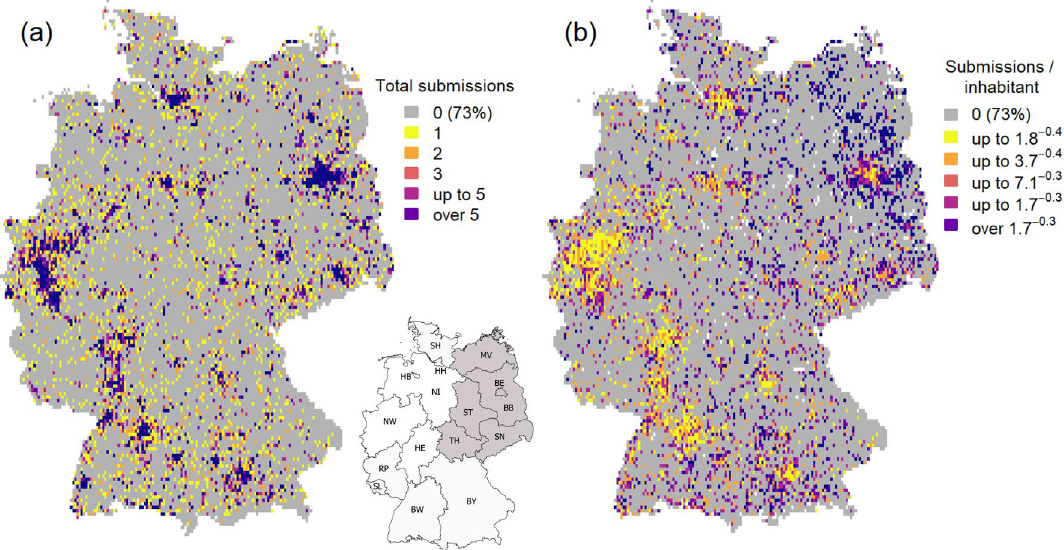
Figure 4. Federal states of Germany ( SH Schleswig-Holstein, HH Hamburg, HB Bremen, NI Lower Saxony, NW North Rhine-Westphalia, HE Hesse, RP Rhineland Palatinate, SL Saarland, BW Baden-Wuerttemberg, BY Bavaria, MV Mecklenburg Western-Pomerania, BB Brandenburg, BE Berlin, ST Saxony-Anhalt, SN Saxony, TH Thuringia). ( a ) Raster grid of Germany (5 × 5 km 2 cell size) of total submission numbers. ( b ) Raster grid of Germany (5 × 5 km 2 cell size) showing per-capita submission rates (white grid cells = zero submission and zero/invalid population data). Both raster maps were created in R version 3.5.2., the German map outlining the federal states was drawn using QGis version 3.4.2. (Quantum GIS Geographic Information System,